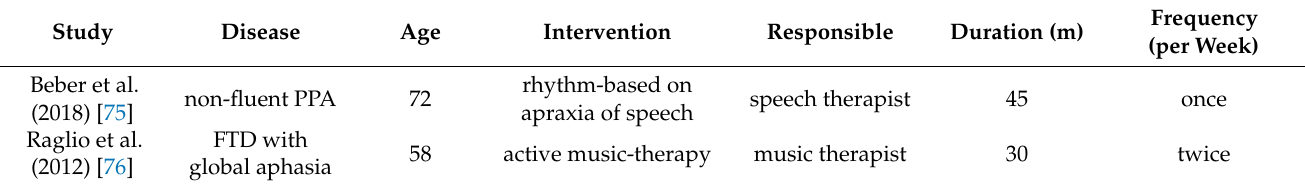
Table 2. Main characteristics of the two case studies included in the